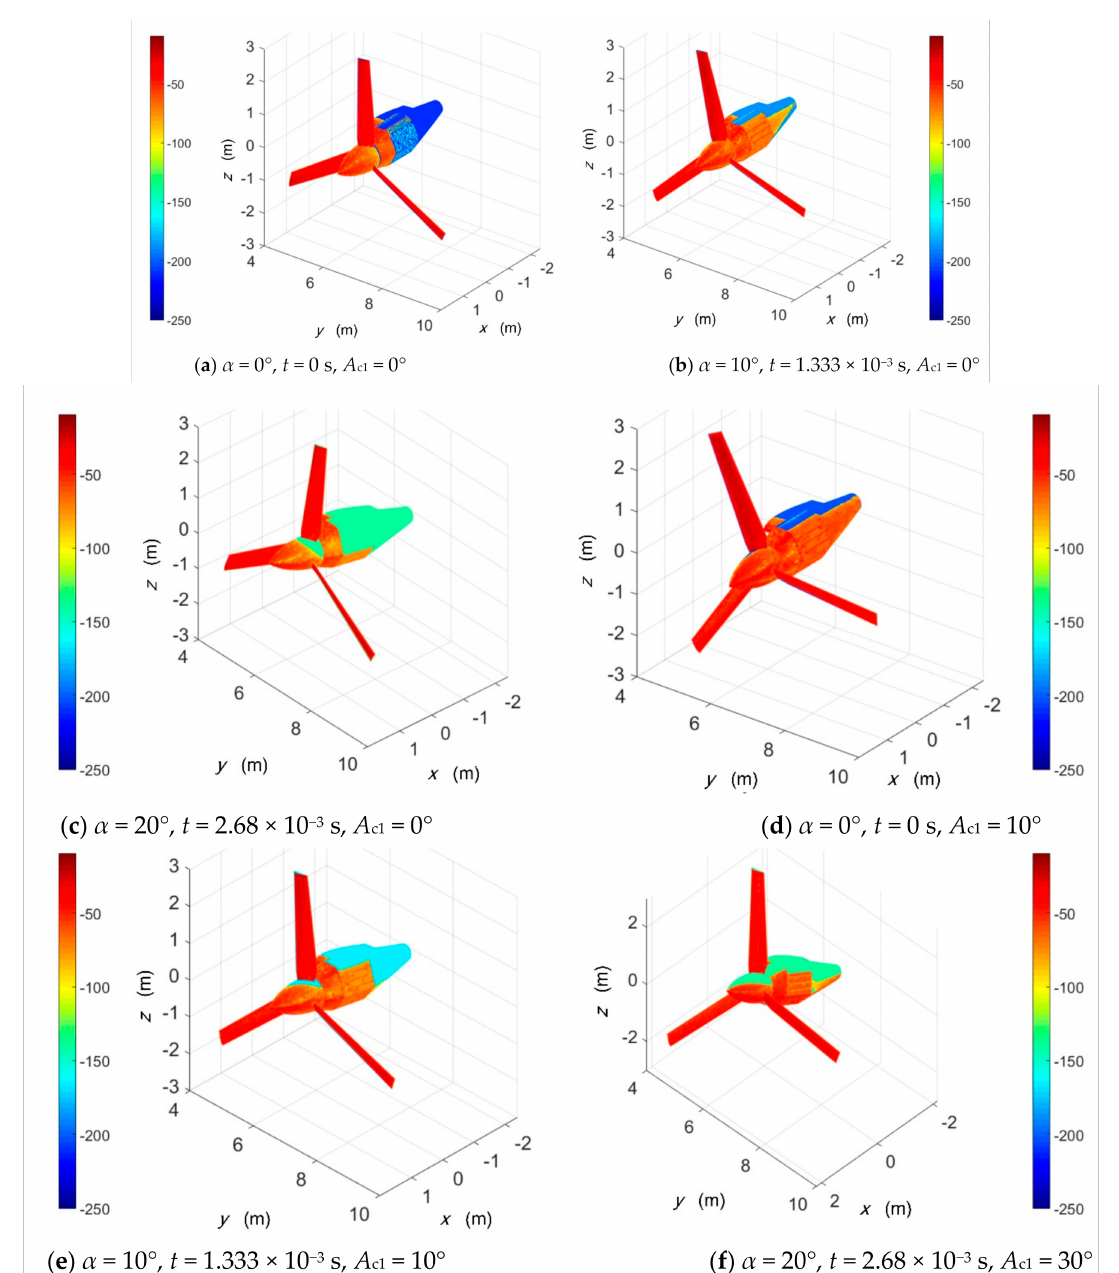
Figure 5. Surface electromagnetic scattering characteristics of rotor 1 and cabin 1, f rh = 10 GHz, n r1 = 1500 r/min, β = 0 ◦ , RCS unit: dBm 2 . ( a ) Surface scattering characteristics at α = 0 ◦ , t = 0 s, A c1 = 0 ◦ . ( b ) Surface scattering characteristics at α = 10 ◦ , t = 1.333 × 10 − 3 s, A c1 = 0 ◦ . ( c ) Surface scattering characteristics at α = 20 ◦ , t = 2.68 × 10 − 3 s, A c1 = 0 ◦ . ( d ) Surface scattering characteristics at α = 0 ◦ , t = 0 s, A c1 = 10 ◦ . ( e ) Surface scattering characteristics at α = 10 ◦ , t = 1.333 × 10 − 3 s, A c1 = 10 ◦ . ( f ) Surface scattering characteristics at α = 20 ◦ , t = 2.68 × 10 − 3 s, A c1 = 30 ◦